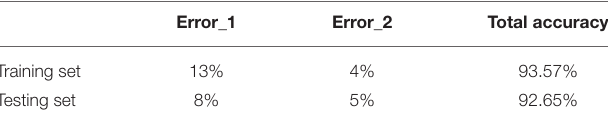
TABLE 5 | Prediction performance using TPA, PAI-1, TC, HDL-C, LDL-C, and BMI as